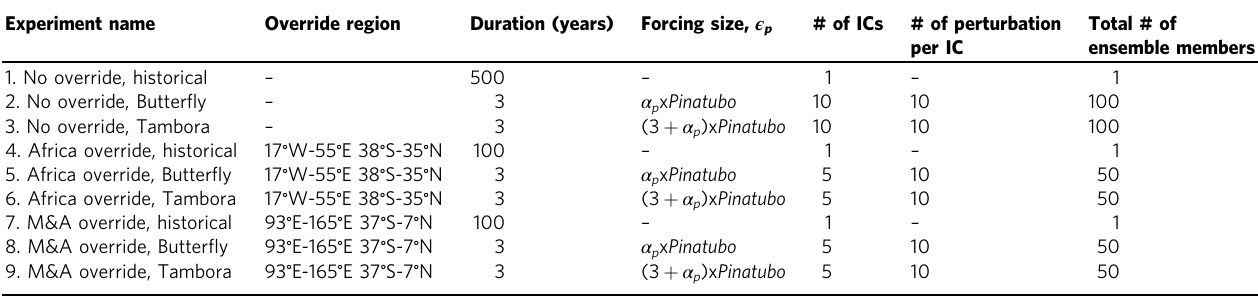
Table 4 List of control and perturbed grand-ensemble simulations with and without land surface temperature override over Africa and Maritime&Australia (M&A) continents for each ENSO onset listed in Table 2: La Niña, Neutral, weak El Niño, and extreme El